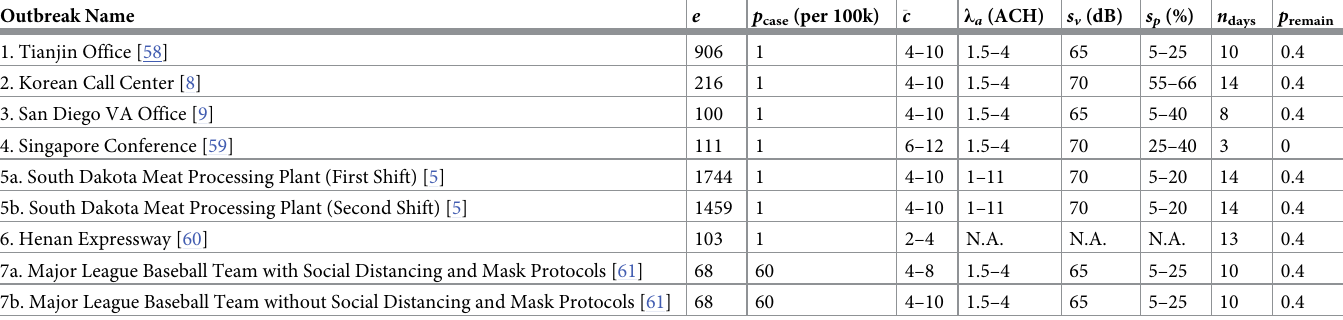
Table 1. Outbreak reports for workplace outbreaks. Model parameters associated with outbreak reports used for validation. Outbreak